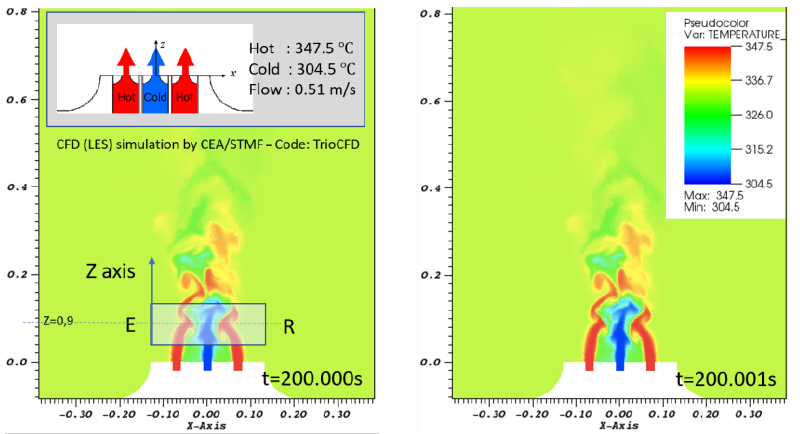
Figure 2. Two maps from the PLAJEST CFD simulation and representation of the insonified volume.